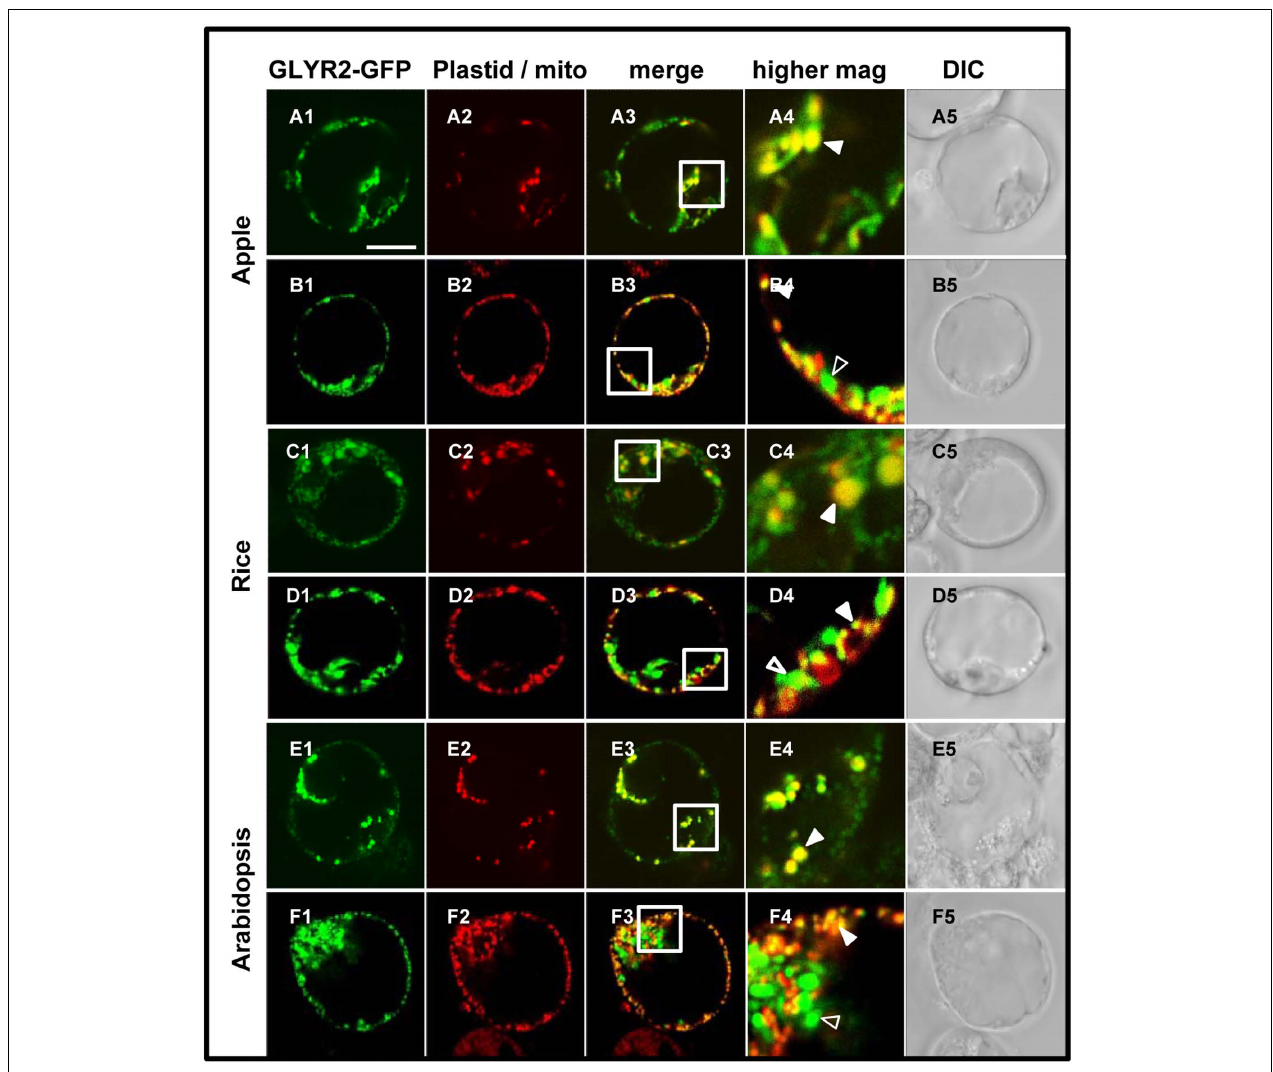
FIGURE 4 | Plastid and mitochondrial localization of Md GLYR2, Os GLYR2, or At GLYR2 in Arabidopsis protoplasts. (A–F) Representative CLSM images of Arabidopsis protoplasts (co)expressing (as indicated by the panel labels) Md GLYR2-GFP, Os GLYR2-GFP, or At GLYR2-GFP and either the plastid marker PDC pl -E2-Cherry or stained with Mitotracker. Processing and viewing of protoplasts using CLSM are described in the Section ‘Materials and Methods’. Shown also is the corresponding merged and DIC images for each cell. Boxes in the merged images represent the portion of the cell shown at higher magnification in the panel to the right. The yellow color in the merged images indicates co-localization; solid arrowheads indicate obvious examples of co-localization, whereas open arrowheads indicate obvious examples of non-co-localization. Scale bar in A = 10 µ